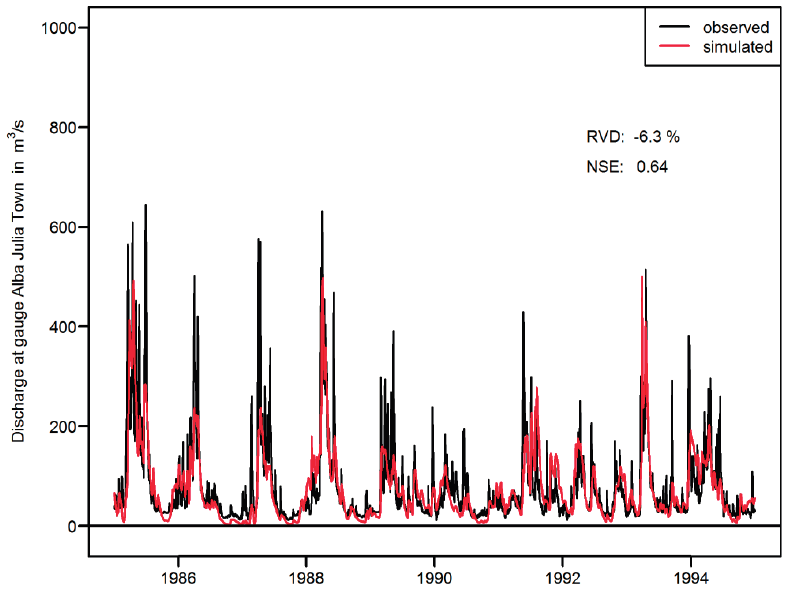
Figure 3. Calibration of Mures River model until Alba Julia gauge, over period from 1986 to 1994.